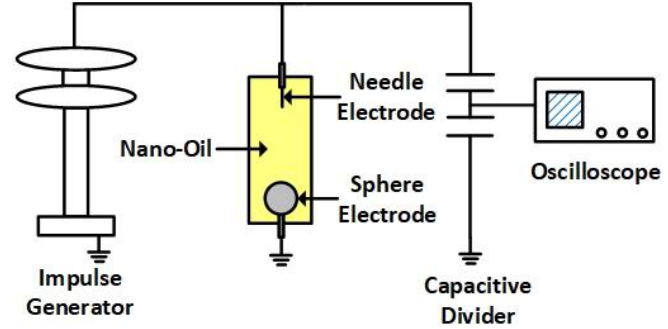
Figure 2. The sketch of test setup.